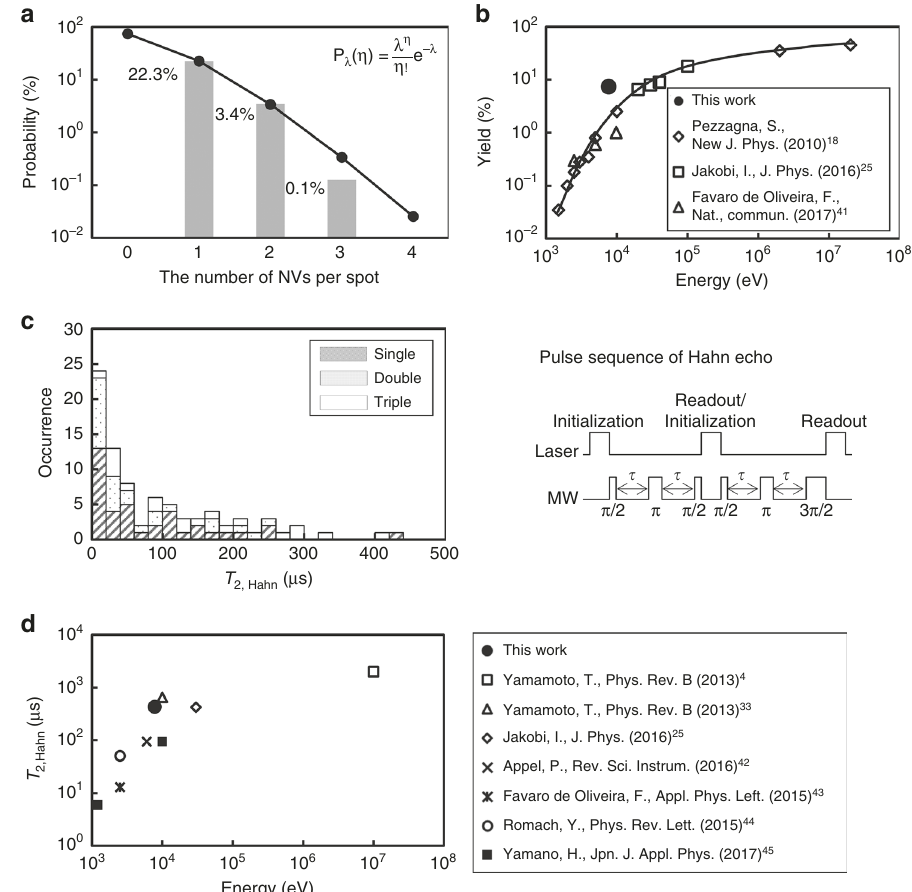
Fig. 2 Creation yields and coherence times. a Ratio of created fl uorescent spots to implanted C 5 N 4 H n ions from a total measured area of 10,400 μ m 2 . The numbers of single, double, and triple NV centres were 1,589 (22.3%), 244 (3.4%), and 9 (0.1%), respectively. The closed circles and solid line represent the best fi tting Poisson distribution ( λ = 0.30). The fi tting was conducted in a linear scale and the plotting is represented in a logarithmic scale. b Creation yield depends on the ion acceleration energy. The closed circle shows the creation yield of the NV centres in this study, and the open symbols show the data from previous studies. It is clear that the creation yield of 7.4% achieved in this study is higher than those reported from previous studies. c Histogram of the coherence time, T 2,Hahn , measured by Hahn echo pulse sequence shown next to the histogram. The hatched, dotted, and open bars show the T 2,Hahn values observed from the single, double, and triple NV centres, respectively. The total numbers of measured T 2 , Hahn for single, double, and triple